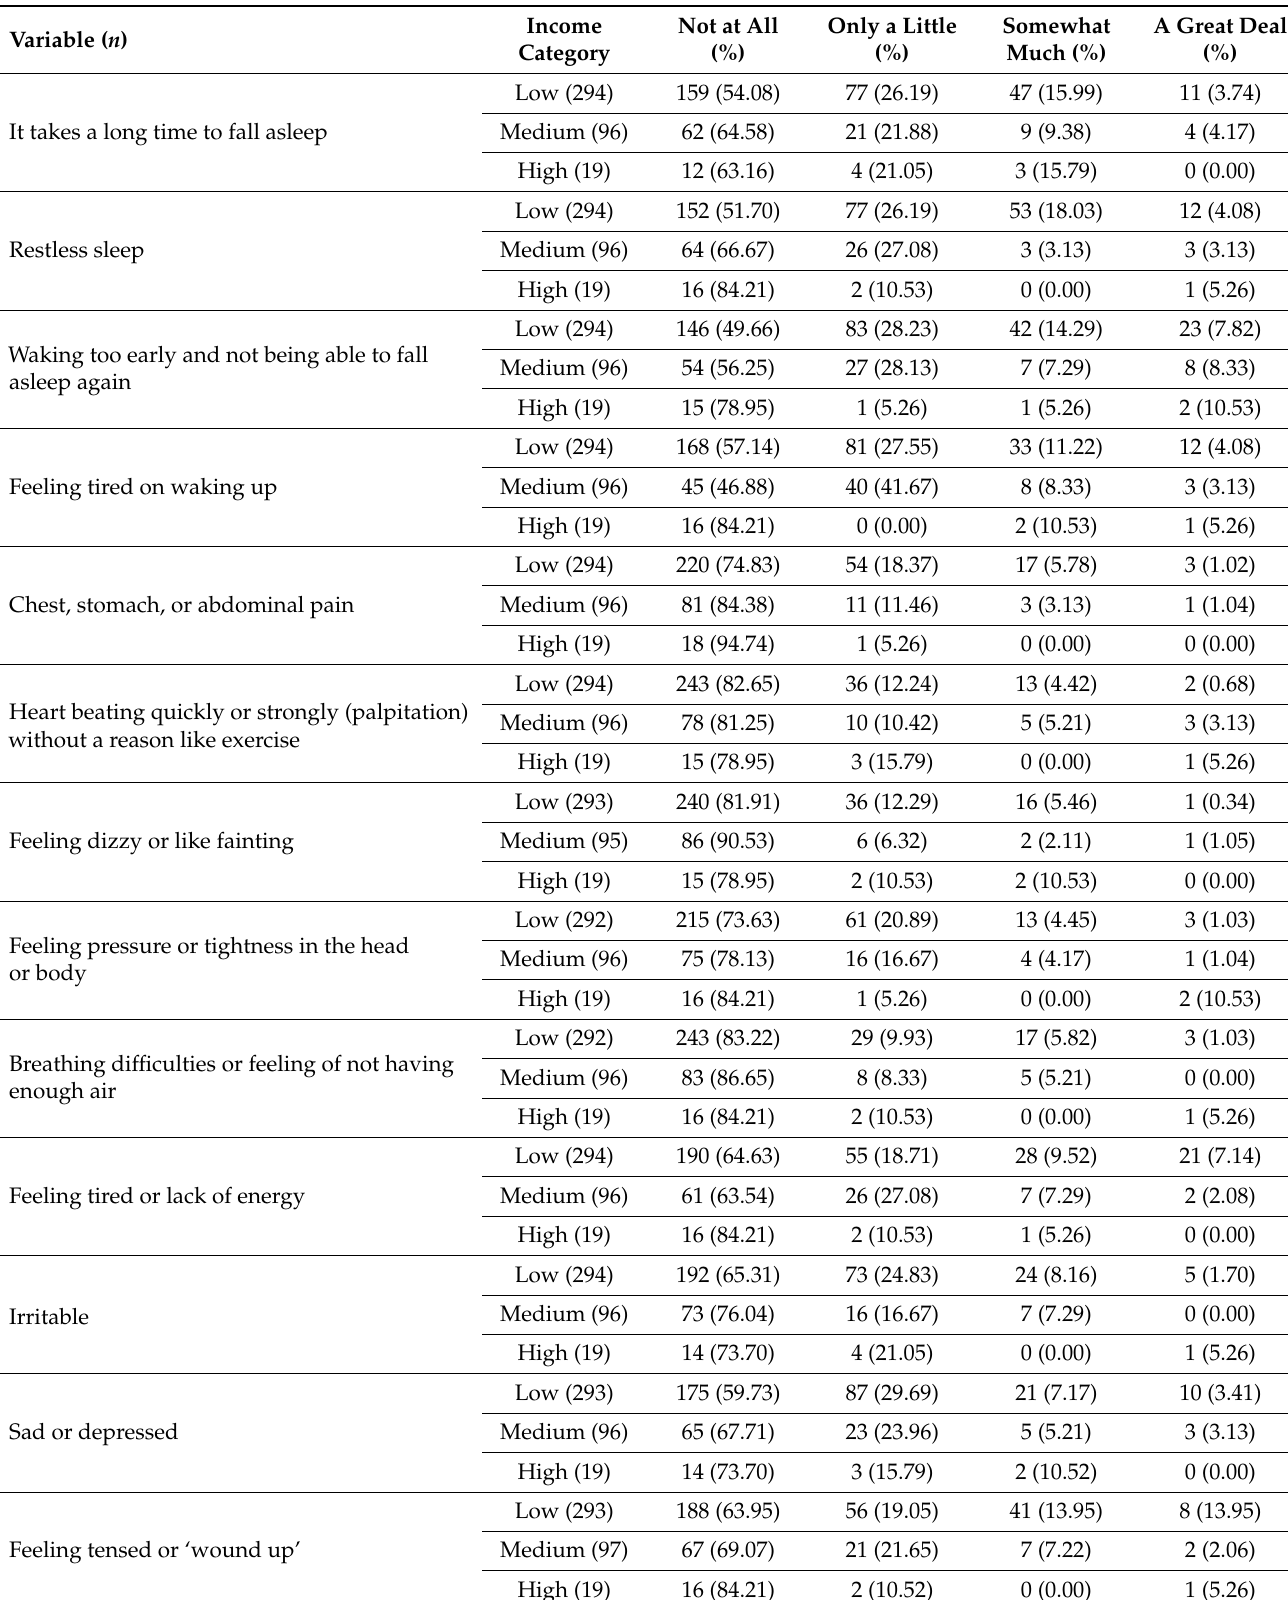
Table 4. Psychological stress and self-rated quality of life of respondents per socio-economic earning category due to the impact of